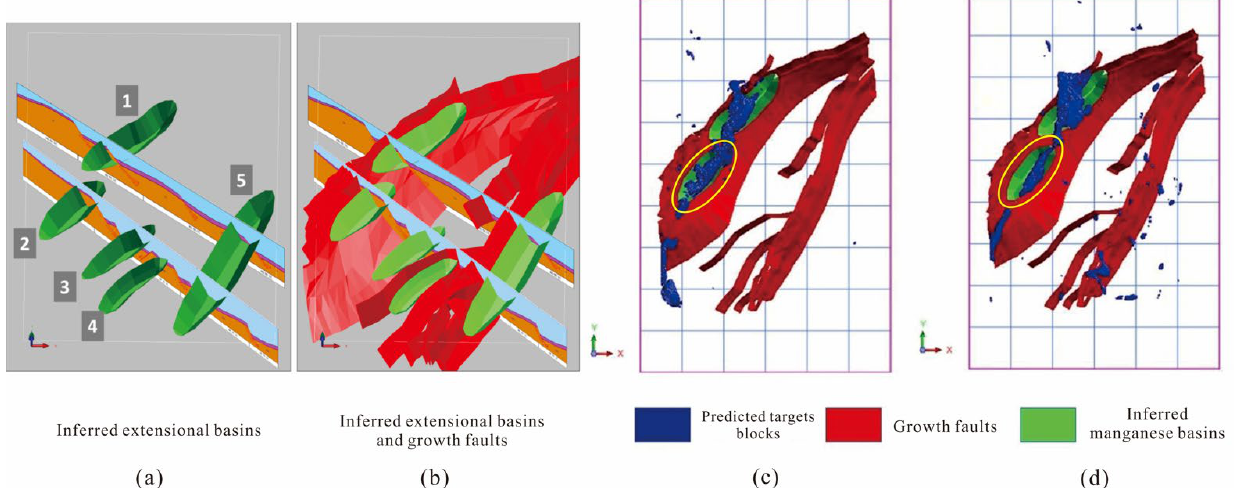
Figure 18. The overlayed diagrams of 3D predicted results and basin and growth faults: ( a ) the 3D model of inferred extensional basins, ( b ) the 3D overlayed diagram of inferred extensional basins and growth faults, ( c ) the overlayed diagram of prediction results and basins and faults under the 3D CNN model in test 5, and ( d ) the overlayed diagram of transfer learning in test 6 with basins and faults (the threshold value is 0.65).